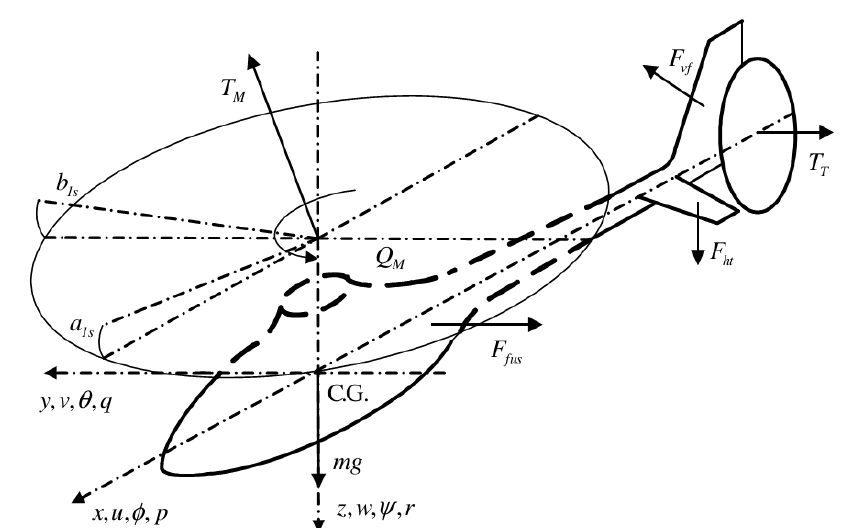
Figure 1. Forces and moments acting on the rotorcraft with reference to the body-fixed refer- ence